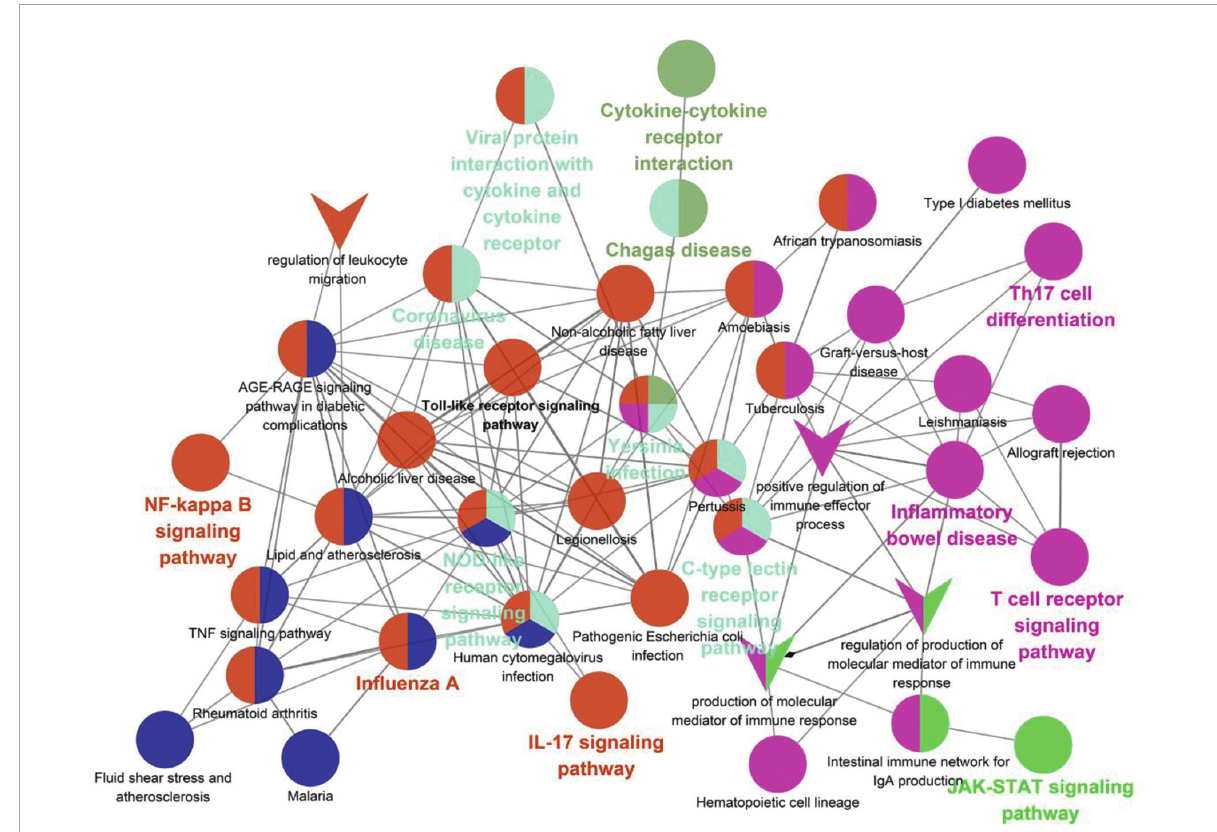
FIGURE7 Correlation of KEGG enrichment of hub gene with GO-BP. The circle represents the pathway, and the “V” shape represents GO-BP. The node color means that the pathway is clustered into the same clusters with similar functions. The bolded pathway name means the p -value is smaller in that clusters with high